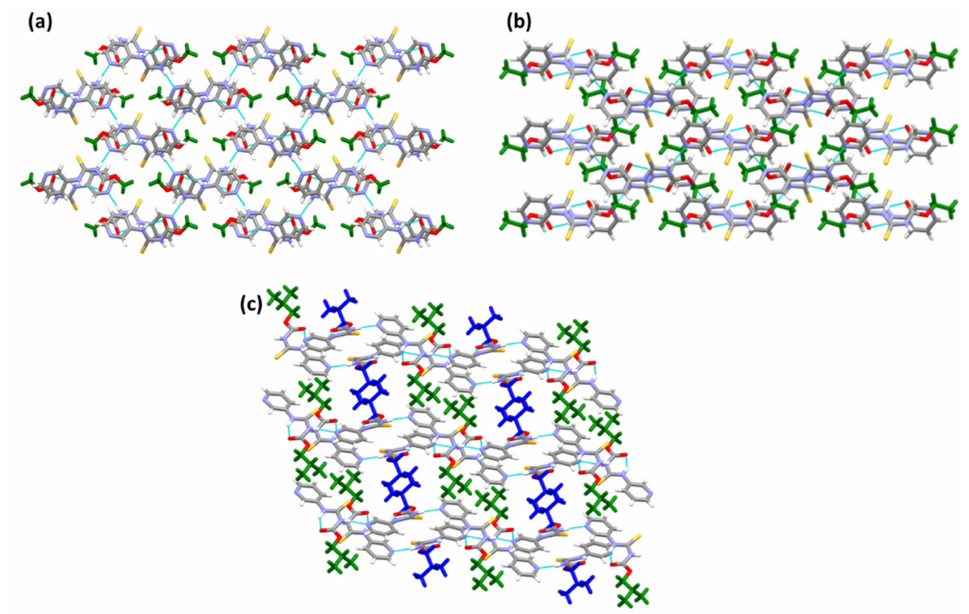
Figure 5. Crystal packing in the structures of ( a ) A1 , ( b ) A2 , and ( c ) A 3 .